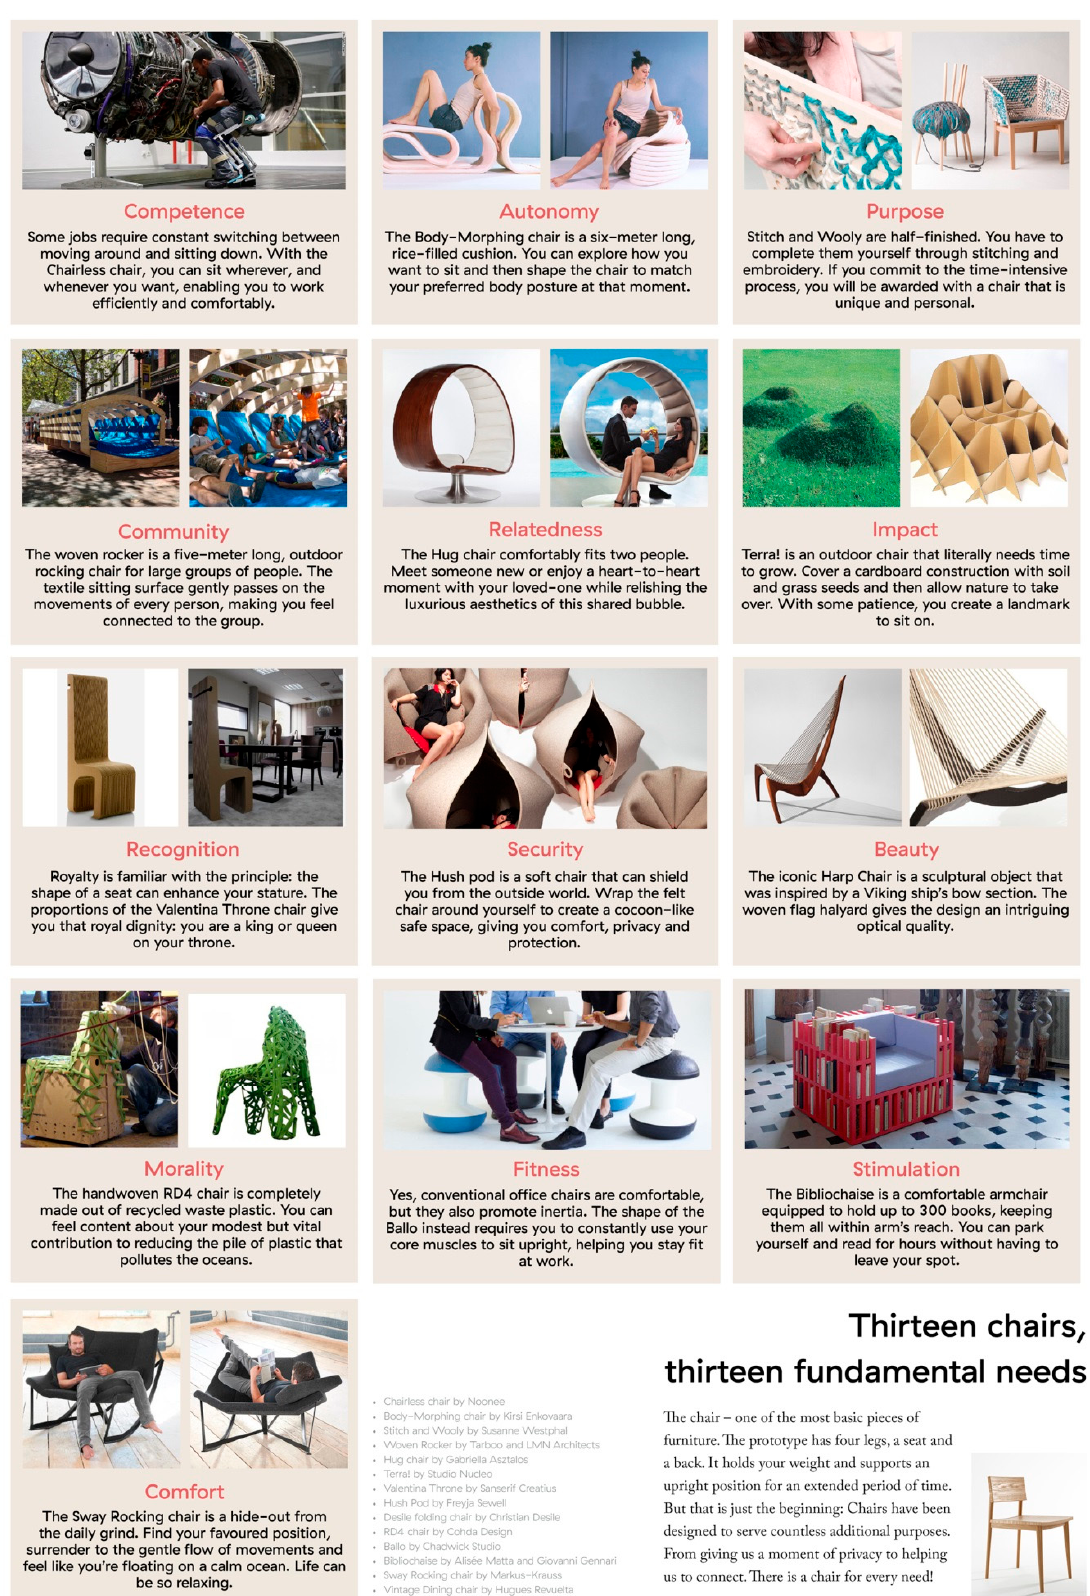
Figure 5. Poster with thirteen chairs representing thirteen fundamental needs.